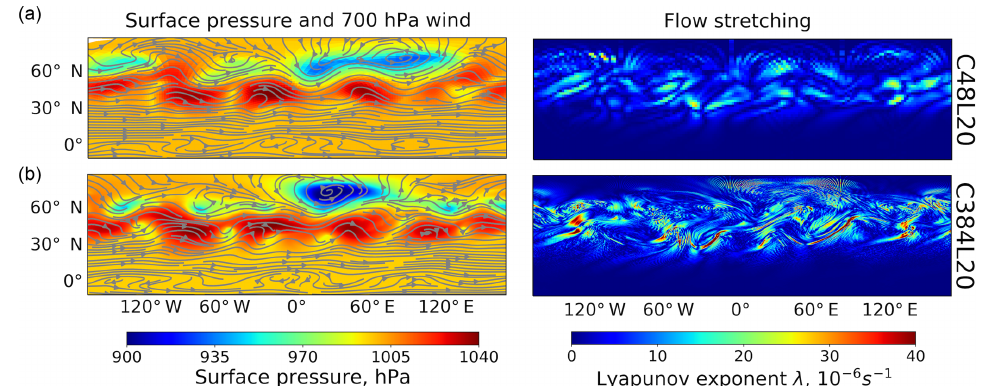
Figure 2. Atmospheric flow generated by the FV3 dynamical core in a baroclinic instability test, 16 days after initialization of the test and 8 days after the release of the chemical plume. Shown are surface pressures, 700hPa flow streamlines and Lyapunov exponents λ measuring the stretching of the flow. Panel (a) shows results from the lowest horizontal resolution (C48, ≈ 200km) and (b) shows results from the highest horizontal resolution (C384, ≈ 25km), both with 20 vertical levels (L20). Increasing vertical resolution has little effect on the dynamics, as discussed in the text.